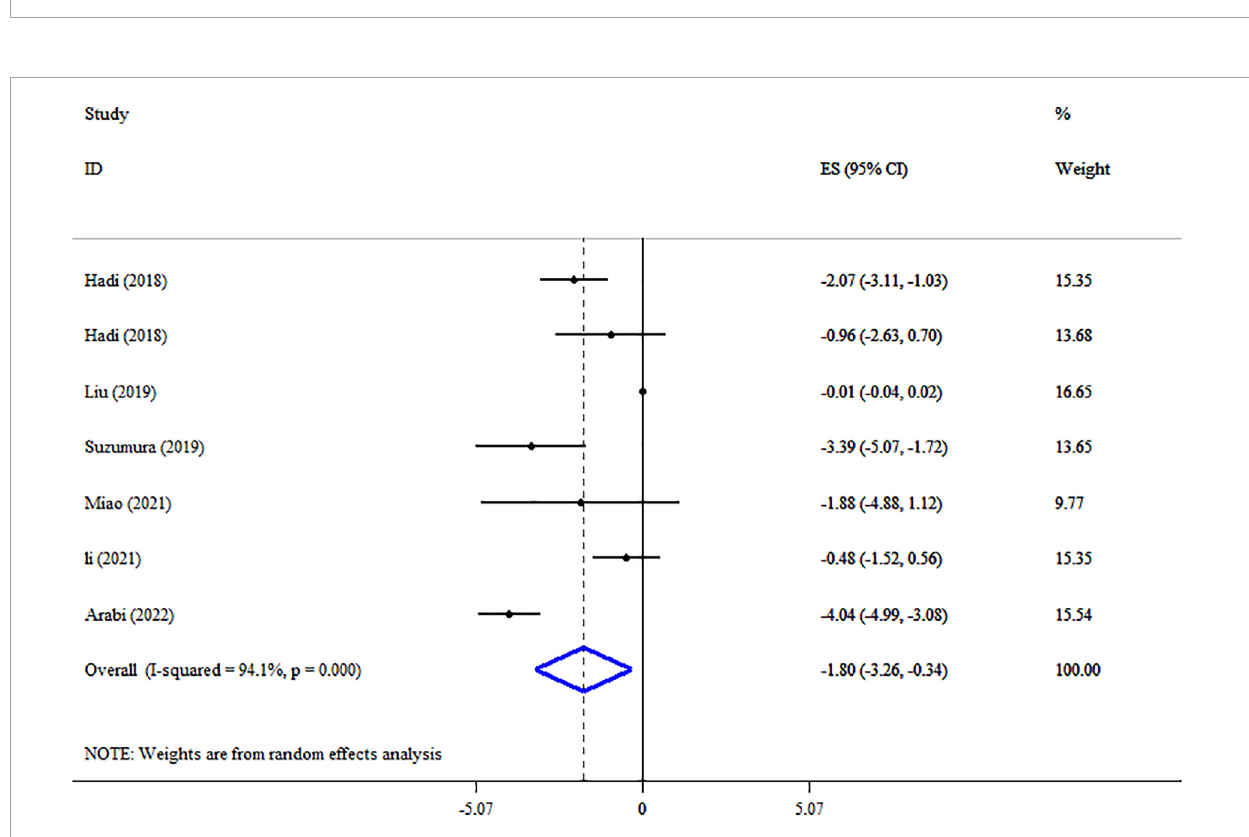
FIGURE4 Forest plot detailing mean difference and 95% confidence intervals (CIs), the impacts of synbiotic supplementation on WC.